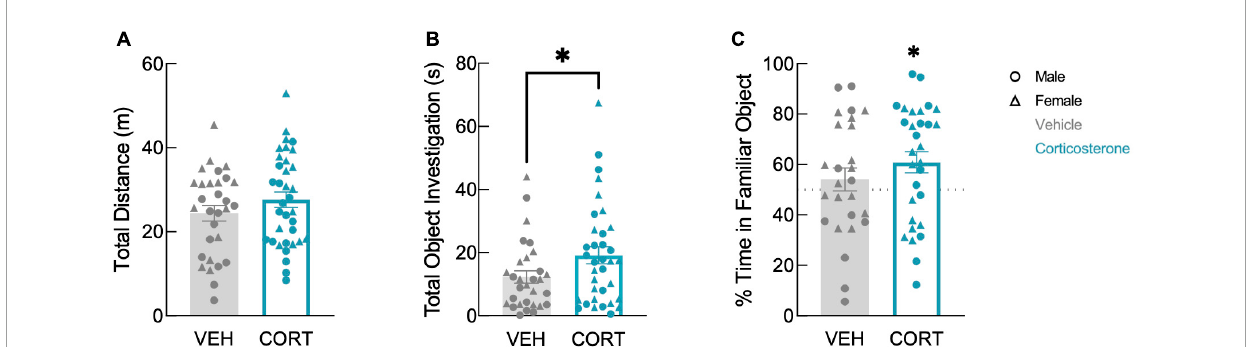
FIGURE3 Corticosterone-treated mice showed improved object recognition. Corticosterone-treated animals exhibited (A) similar levels of overall activity as control animals but (B) spent more time investigating the objects. Corticosterone-treated animals demonstrated (C) a preference for the familiar object over the novel object (VEH: N = 30; CORT: N = 35). ∗ P < 0.05.